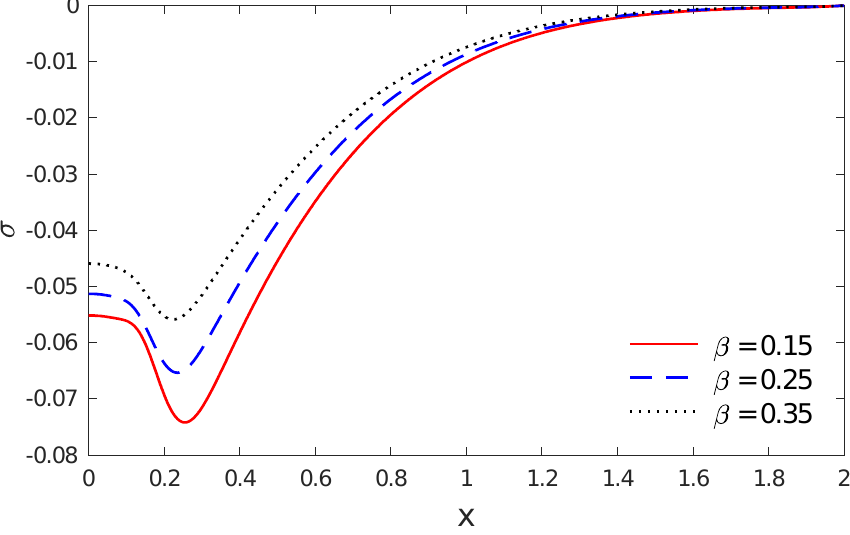
Figure 6 : The variation of fluid stress 𝜎 versus 𝑥 for several values of porosity.